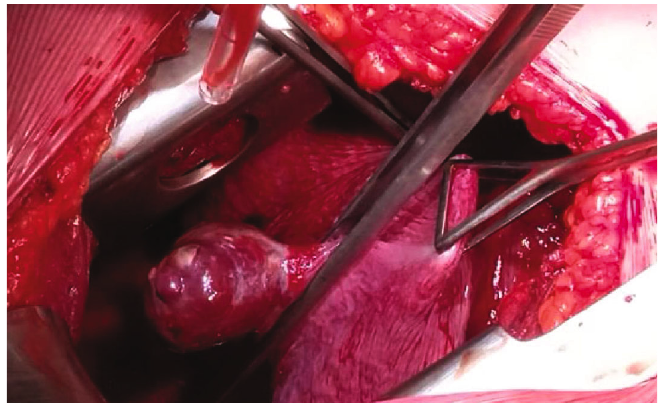
Figure 2: Intraoperative fi nding at 25 +4 weeks of pregnancy of the patient presented with dyspnea on multiple occasions from 20 weeks of pregnancy. Computed tomography pulmonary angiography at 24 weeks of pregnancy revealed isolated arteriovenous